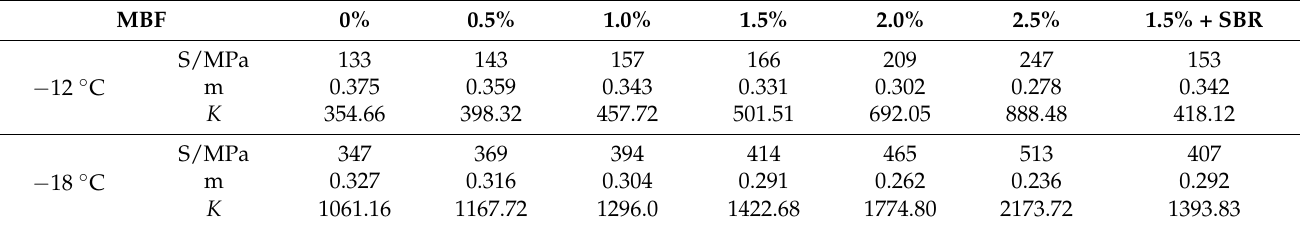
Table 6. Bending rheological parameters of MBF emulsified asphalt.